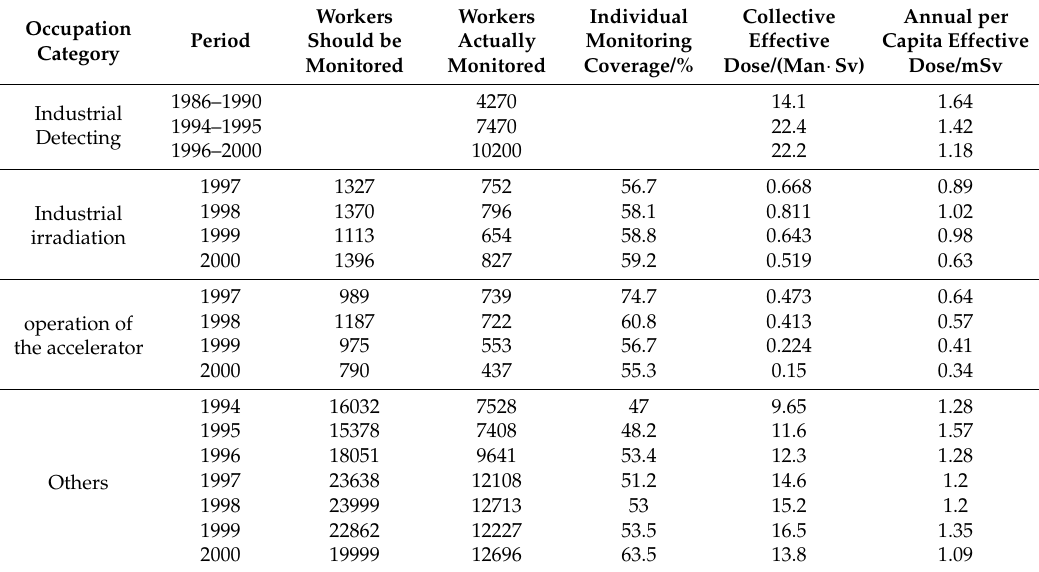
Table 3. Dose levels of occupational exposure in industrial applications